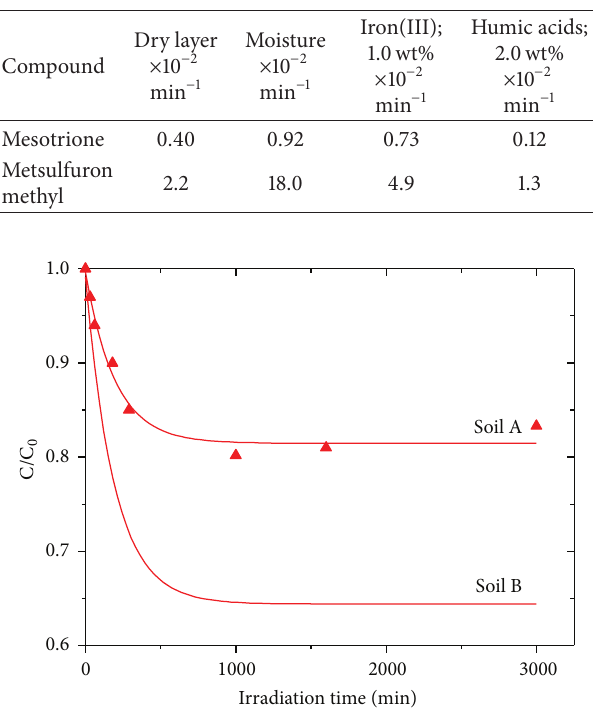
Figure 3: Degradation of mesotrione at the surface of soil A and soil B. Irradiation performed in Sunlight simulator. [Mesotrione] = 5.2 𝜇 mol g −1 . Thickness